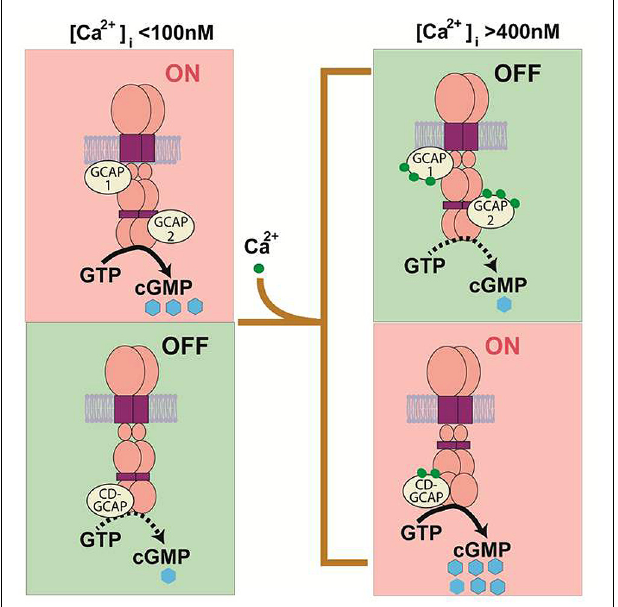
FIGURE 1 | Original theoretical Ca 2+ bimodal ROS-GC transduction model. In the absence of bound Ca 2 + , GCAPs 1 and 2 boost ROS-GC1 catalytic activity. In contrast, S100B boosts ROS-GC1 activity in the Ca 2 + -bound state. GCAPs sense [Ca 2 + ] i < 200 nM while S100B senses [Ca 2 + ] i > 200 nM.Thus in the GCAPs operational mode the S100B switch is “OFF” and in the S100B operational mode the GCAP switch is “OFF” (Upgraded with permission from Sharma, 2010; Sharma and Duda,